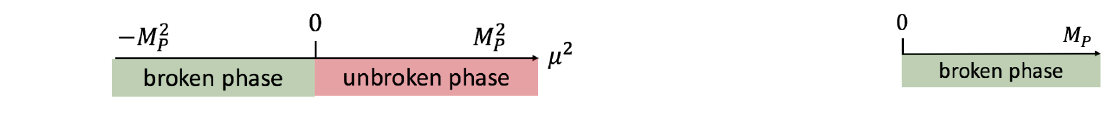
Figure 1 . Left: electroweak phase as a function of the control parameter µ 2 . Right: order parameter of the electroweak phase